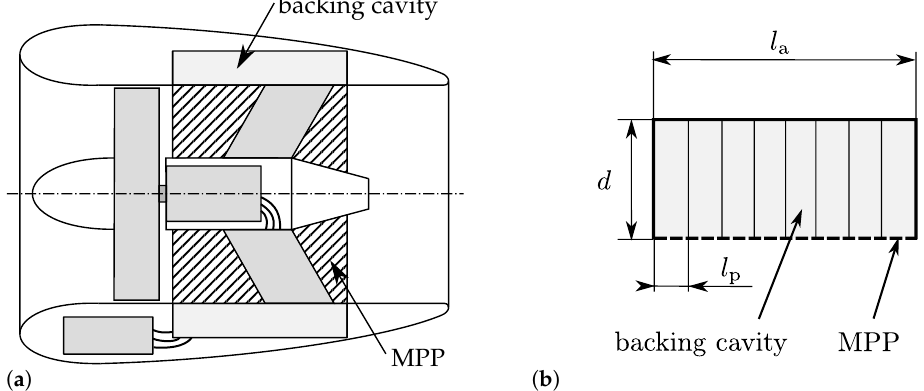
Figure 4. Design and placement of absorber linings: ( a ) placement in EDF; and ( b ) design of the micro-perforated absorber